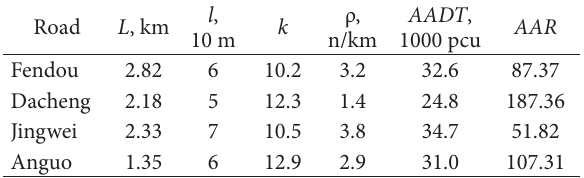
Table 4. Road features and traffic parameters Road